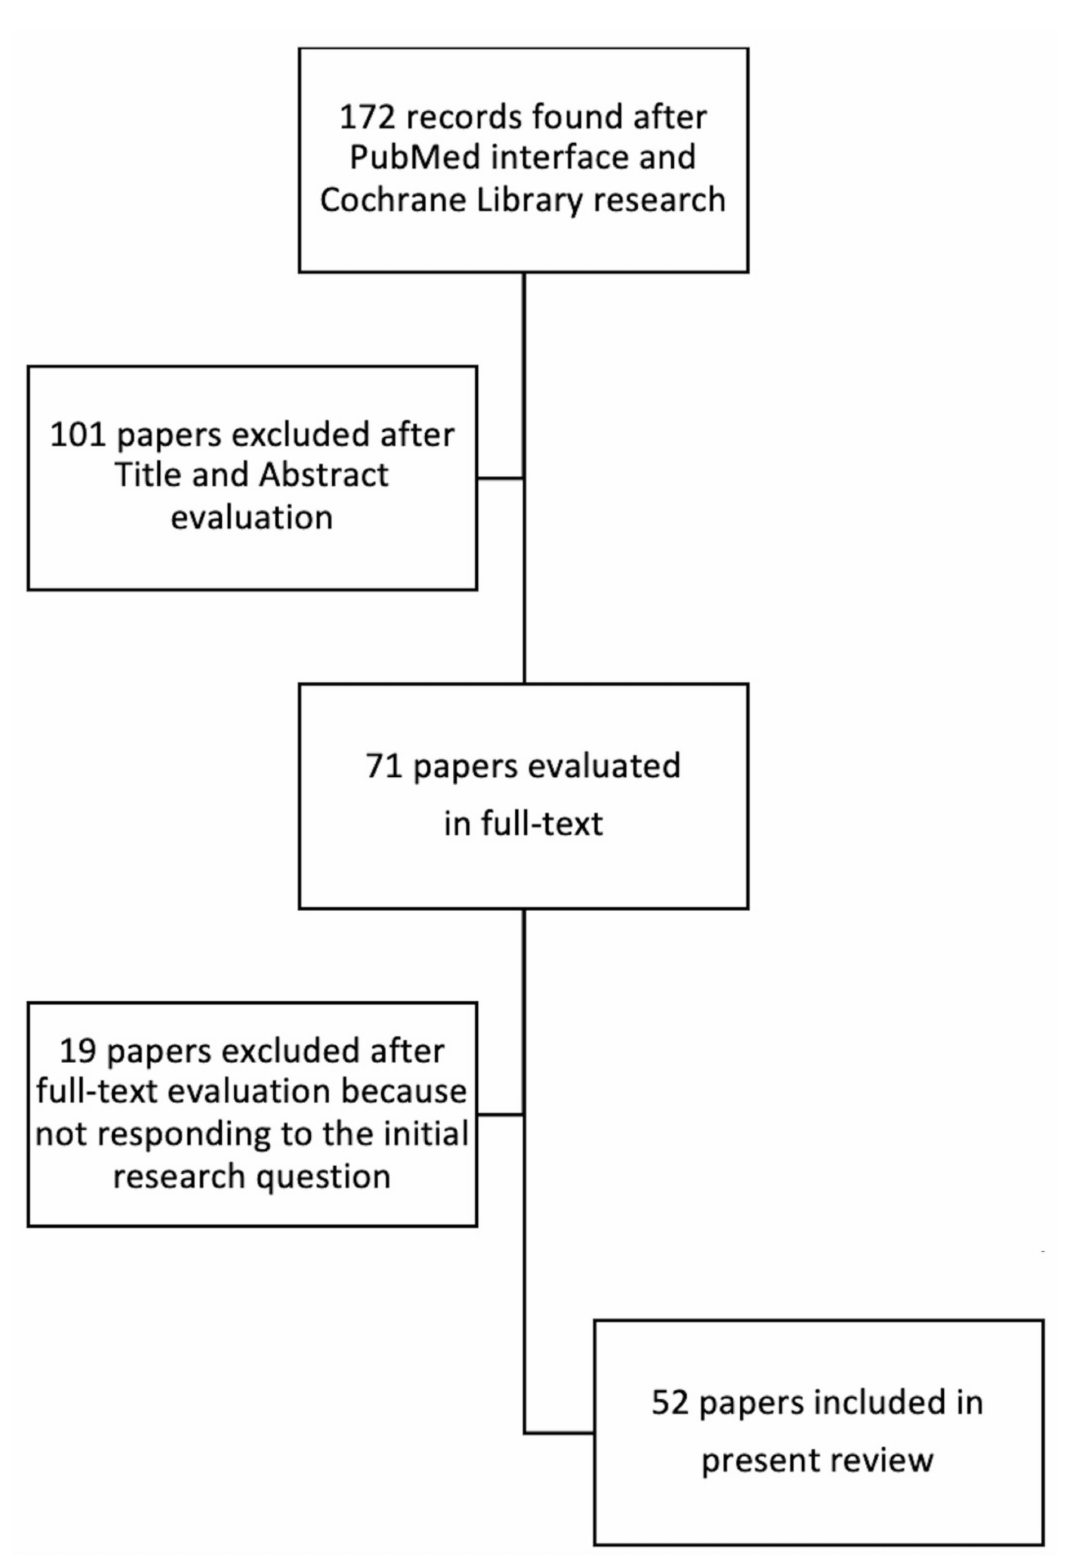
Figure 1. Flow chart reporting studies evaluation and selection